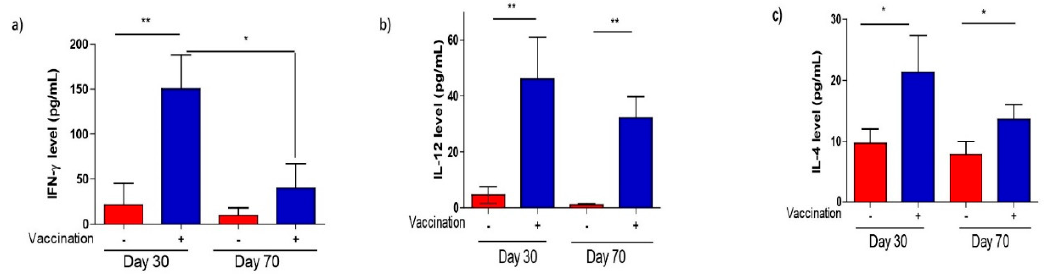
Figure 5. Levels of selected cytokines in the sera of mice 30 and 70 days after ∆ ADSL immunization. ( a – c ) Levels of the indicated cytokines measured by ELISA. Sera from naïve mice were used as controls, and three mice from each group were analyzed. * p < 0.05, ** p < 0.01, NS: not significant, Student’s t -test.